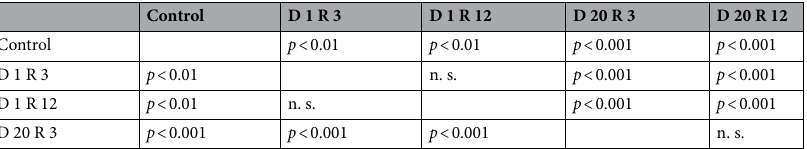
for the enzyme trehalose-6-phosphate synthase, involved in the pathways of trehalose production; aqp 3 and aqp 10 , encoding for aquaporin proteins 3 and 10, which are presumably involved in the rapid transport of water